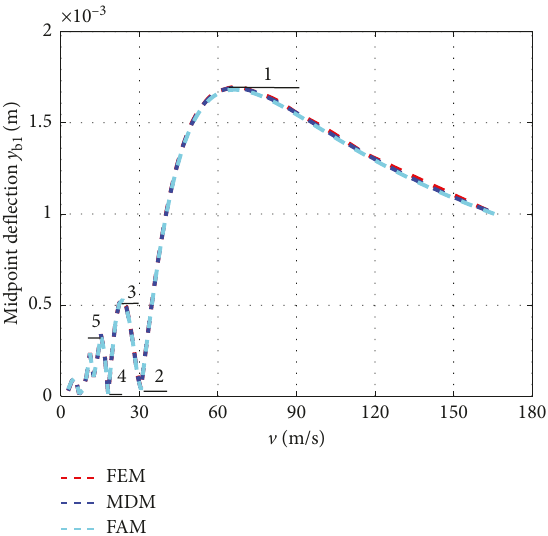
Figure 10: Amplitudes of the bridge free vibration response versus different speeds.